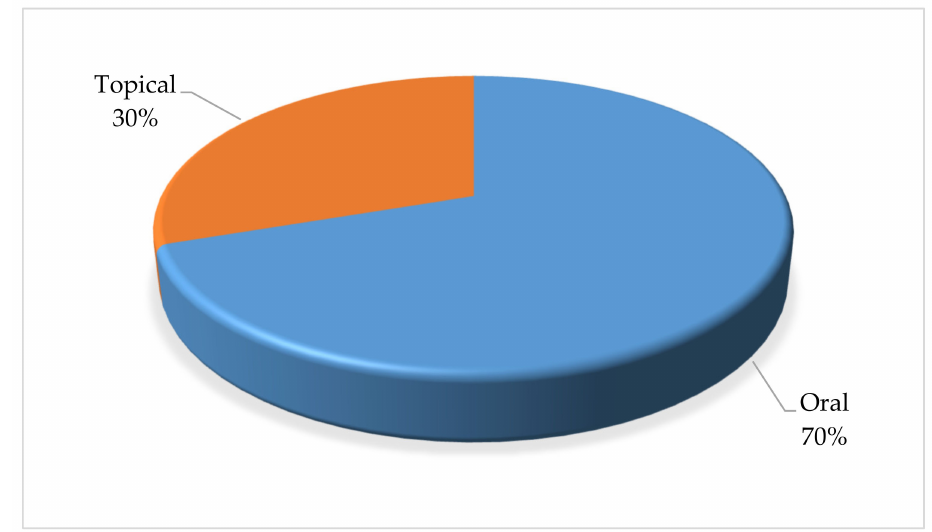
Figure 4. Distribution (%) pattern for the administration of plants used in the treatment of cattle diseases in Ramotshere Moiloa local Municipality, North West Province, South Africa (n =